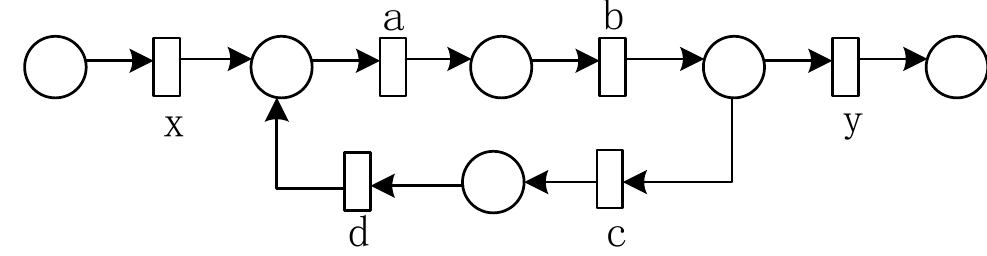
Figure 10. Loop substructure with a sequential structure. Table 8. Invariant set of activities in Figure 9. The Loop Body Is a Sequential Structure